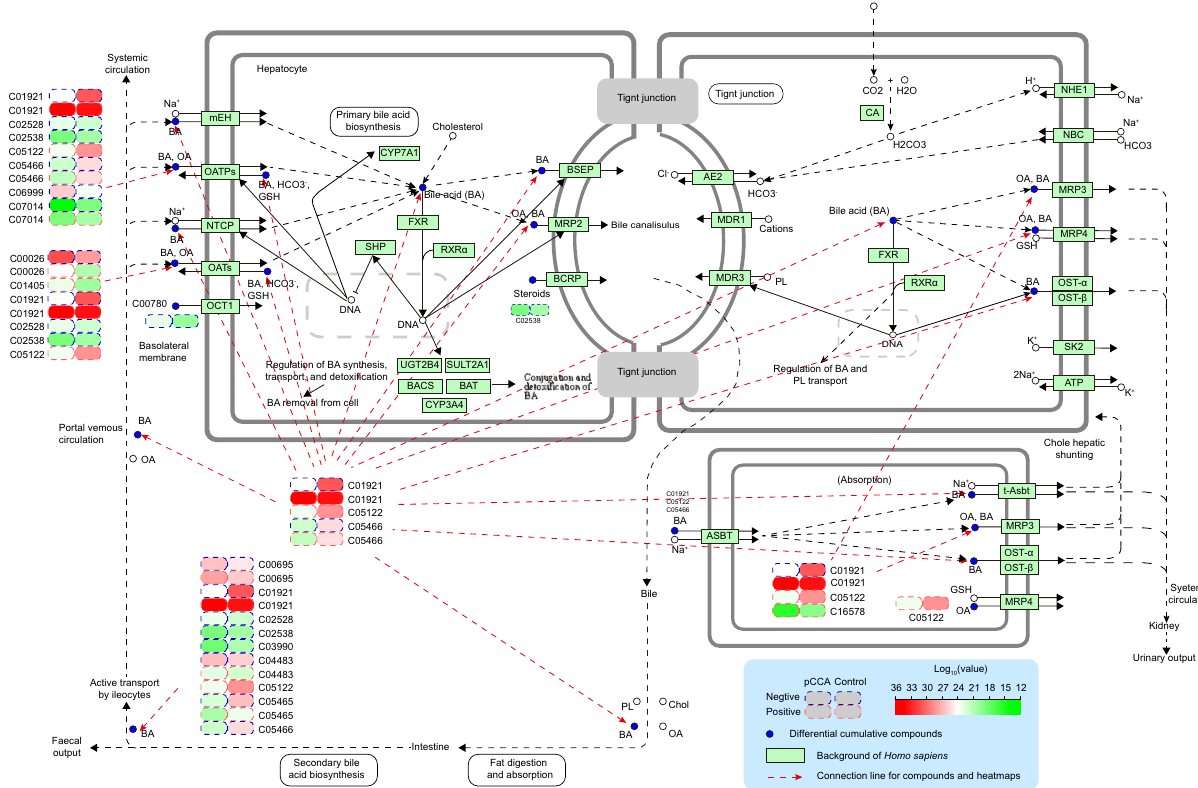
Figure 6. KEGG pathway enrichment analysis of metabolites. Select one of the important pathways shows (bile secretion pathway). The label denotes a potential important target of cholangiocarcinoma discovered in combination with literature review. C01921: Glycocholate; C02528: Chenodeoxycholic acid; C02538: Estrone sulfate; C05466: Glycochenodeoxycholate; C06999: Fexofenadine; C07014: Fluvastatin; C00026: 2-oxoglutaric acid; C01405: Aspirin; C05122: Taurocholic acid; C00695: Cholic acid; C03990: Lithocholic acid; C04483: Deoxycholic acid; C05465: Taurochenodeoxycholic acid; C16578: Morphine